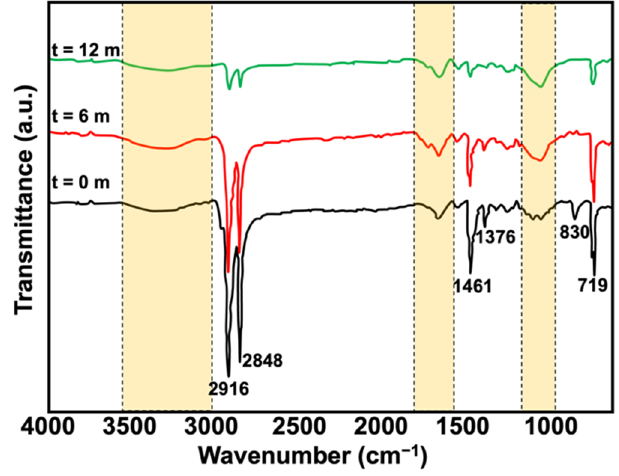
Figure 12. FTIR spectra of rHDPE/NR blends filled with 20 phr of KP before and after 6 and 12 months of natural weathering.